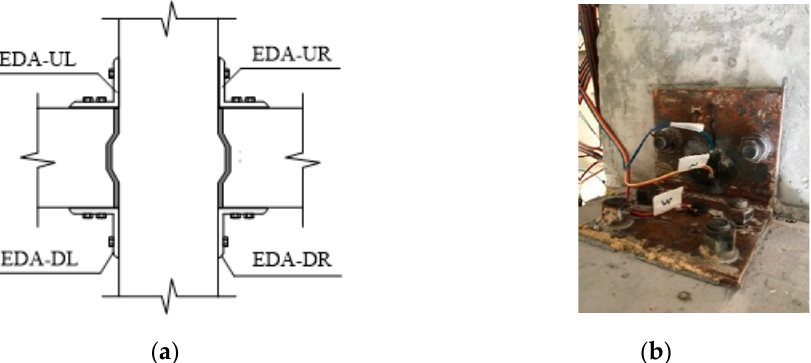
Figure 14. Illustration and photograph of strain gauges: ( a ) strain gauge position; ( b ) photograph.